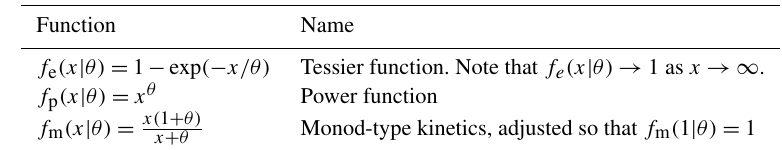
Table A4. Constitutive